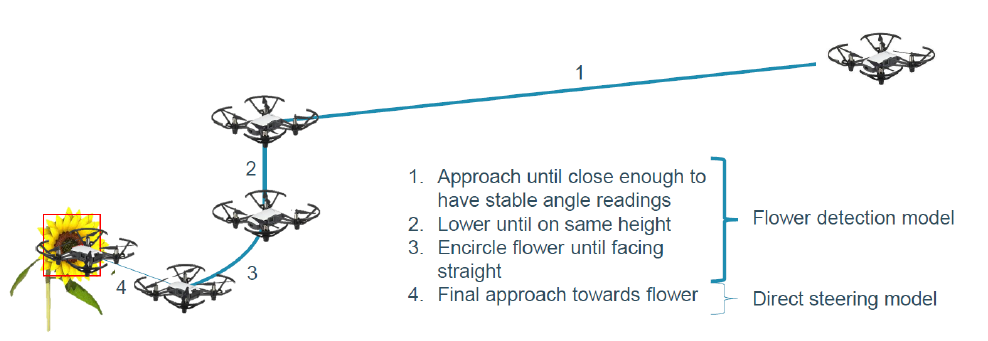
Figure 10. Piece-wise visual servoing approach overview.